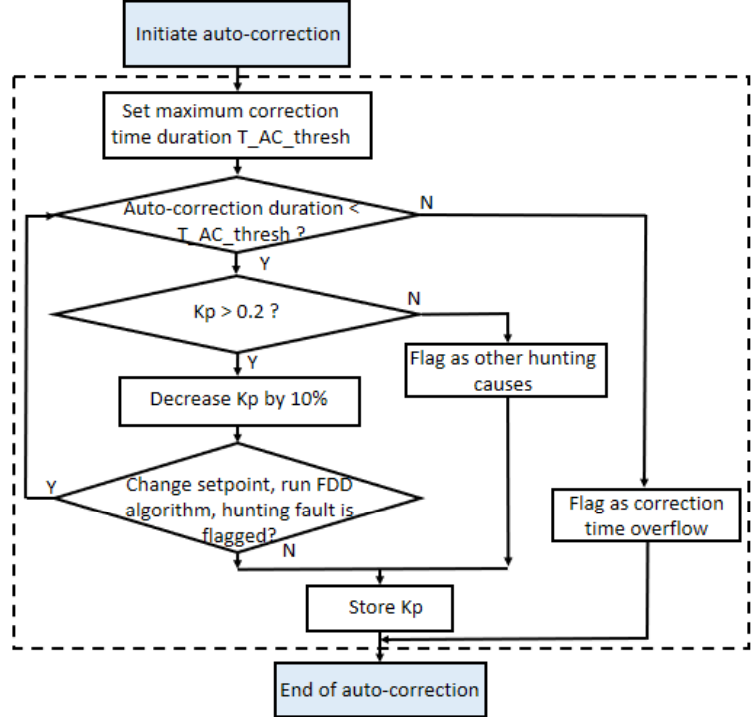
Figure 4. Flowchart of Algorithm 2.4: control hunting due to improper proportion gain (T_AC_thresh - a maximum auto-correction duration threshold, Kp - controller parameter proportion gain).